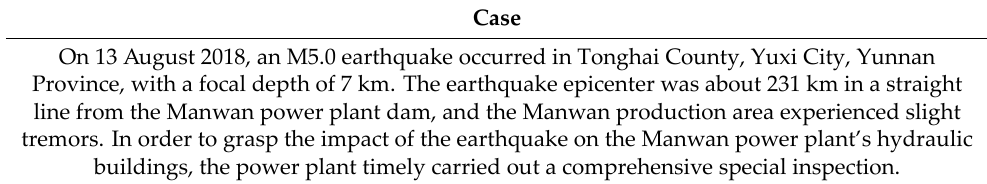
Table 1. Example of dam safety operation